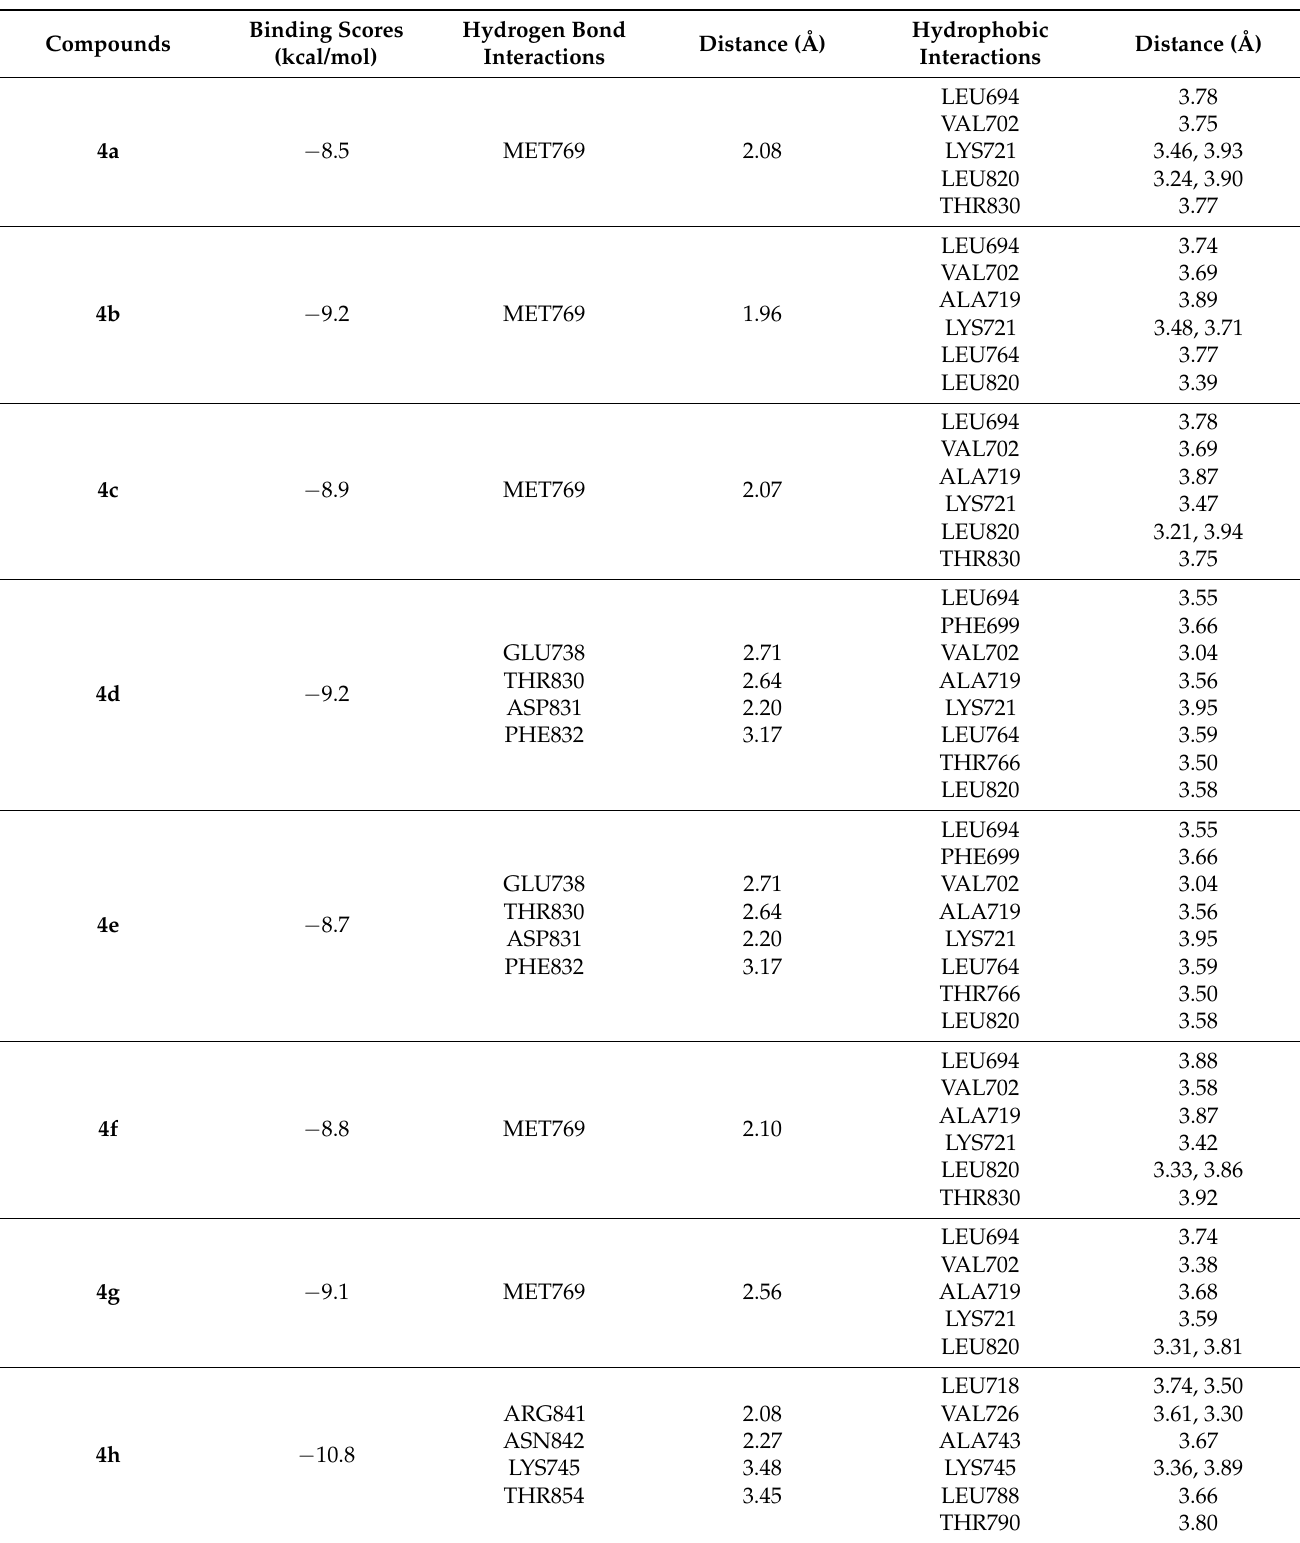
Table 2. The binding scores and interactions of the examined compounds and the Harmine inhibitor inside the binding pocket of receptor of (3W33) for EGFR